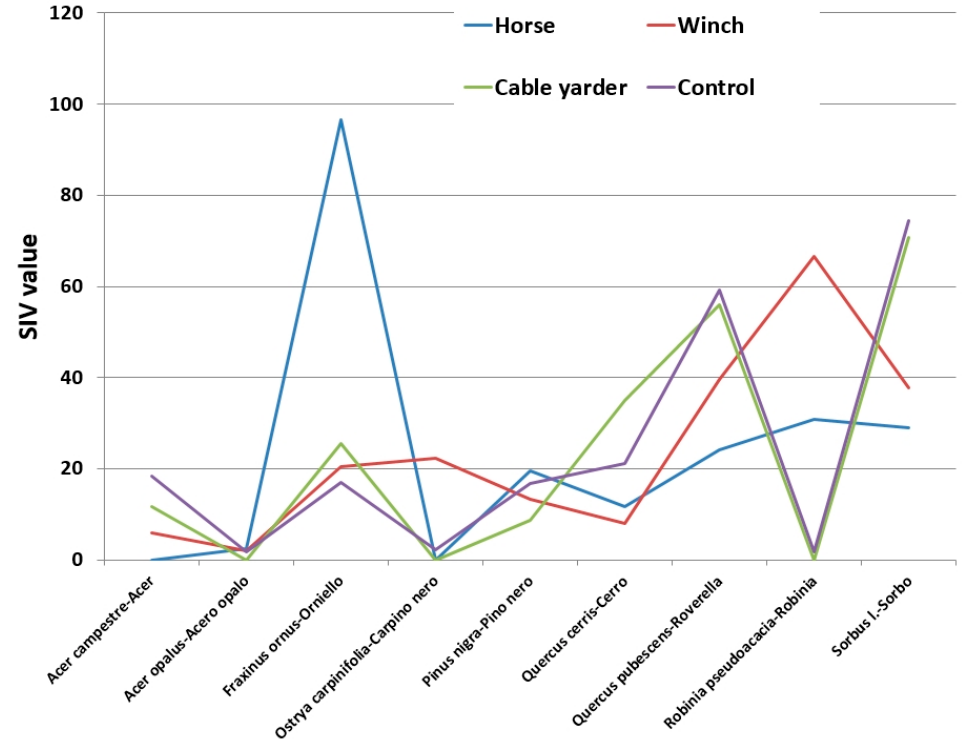
Figure 5. SIV detailed analysis between the treatments and the control for the year 2017.